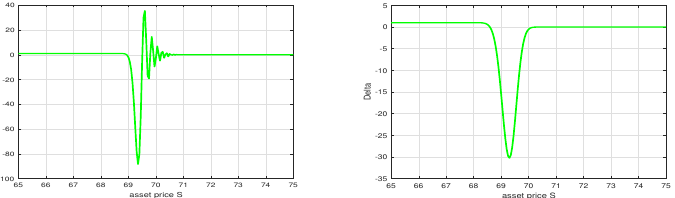
Figure 14. Plots of Delta obtained with the MADE scheme ( left ) and the MMADE scheme ( right ), with parameter values r = 0.01, σ = 0.001, a = − 1250, T = 1, U = 70, K = 50, L = 30, S max = 140, ∆ S = 0.05, ∆ t = 10 − 3 .